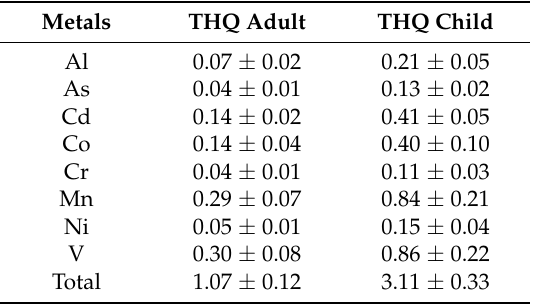
Table 8. Non-Carcinogenic risks (THQ) via inhalation exposure for adult and